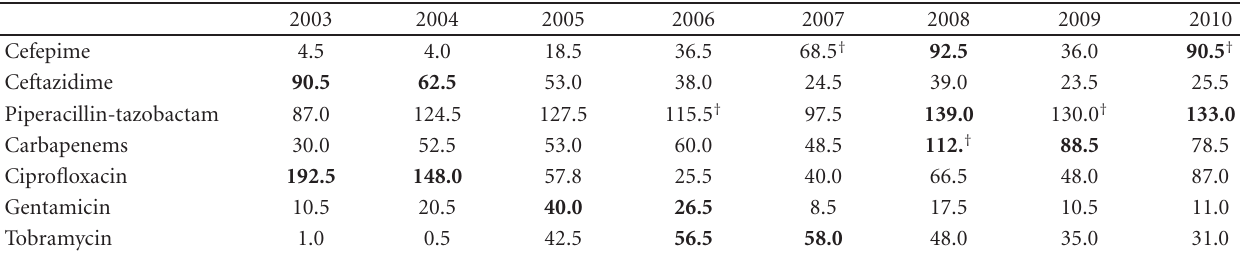
Table 1: Intensive care unit anti-pseudomonal antibiotic utilization (2003–2010).